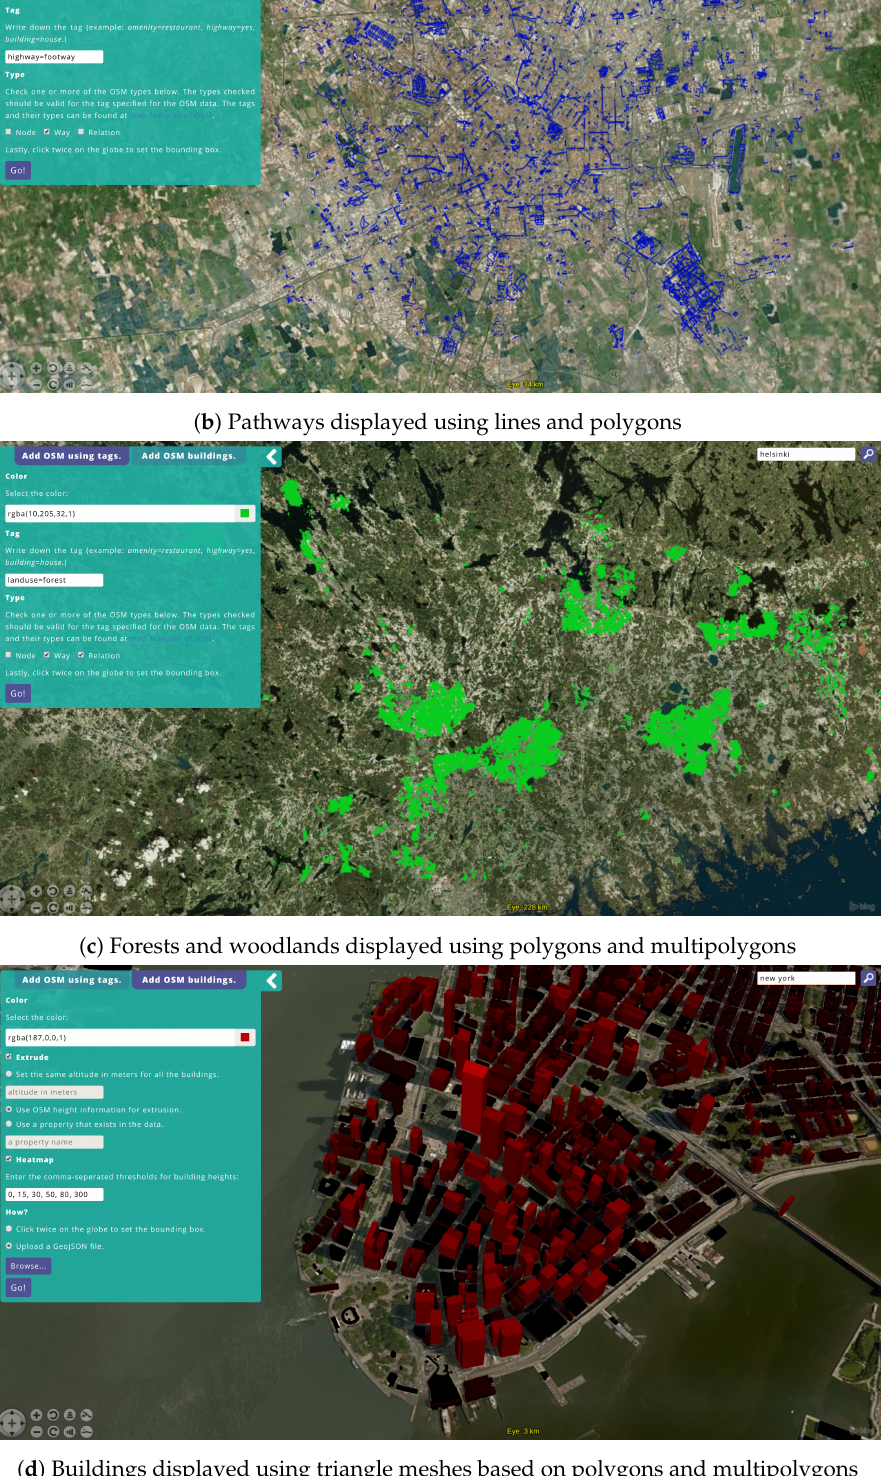
Figure 3. A 2D and 3D visualization of OpenStreetMap (OSM) elements on a virtual globe created using NASA Web WorldWind and 3D OSM Plugin